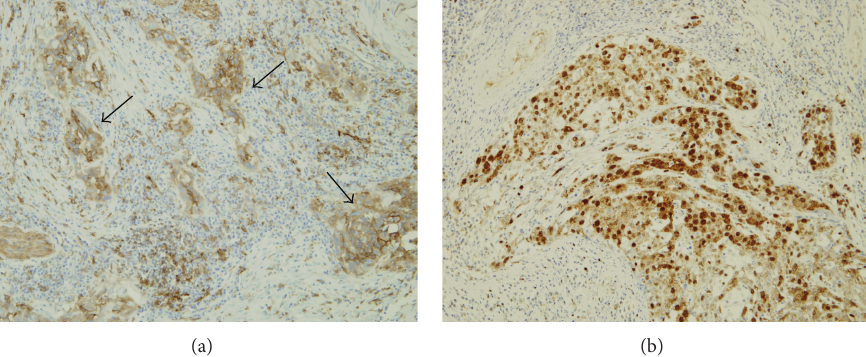
Figure 4: Immunohistochemistry for MHC class II (HLA-DR) (a) and the N-terminus of Foxp3 (b) in biliary tract cancers. In addition to infiltrating mononuclear cells, carcinoma cells are positive for HLA-DR ((a), arrows). The antibody reacting with the N-terminus of Foxp3 (b) highlights the nucleus and cytoplasm of cholangiocarcinoma